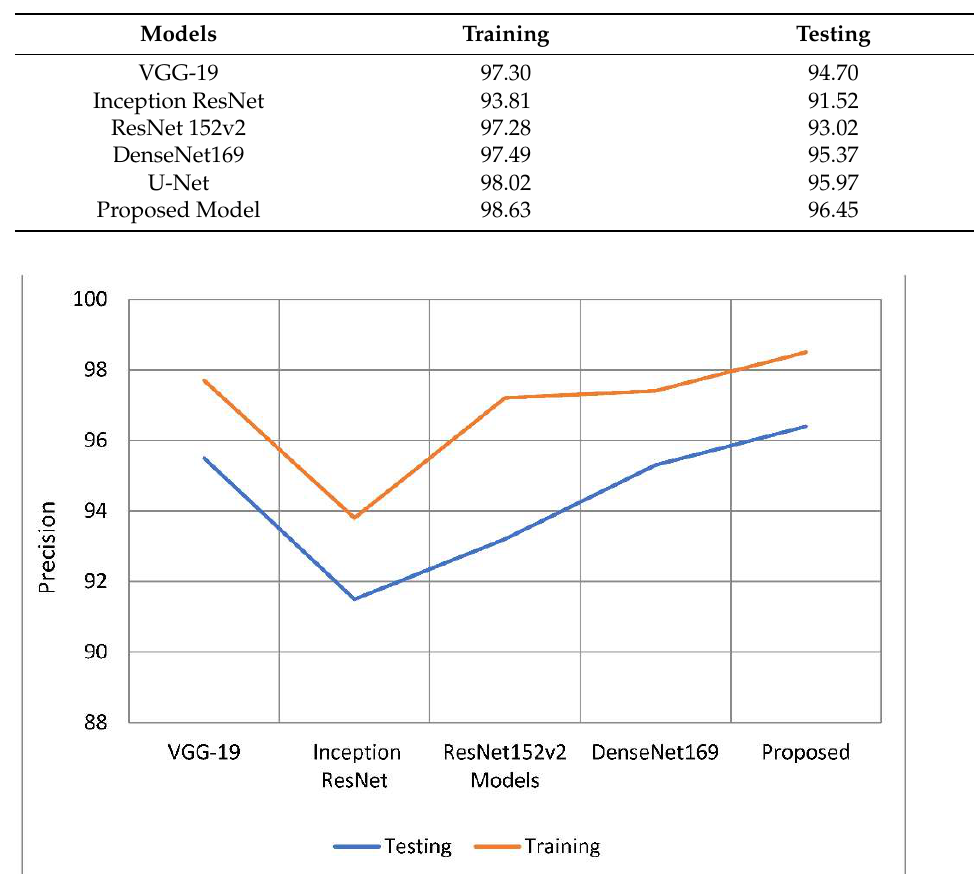
Figure 8. Comparative analysis of the testing and training accuracy of the proposed model with traditional models. Table 2. Accuracy of performance is examined.